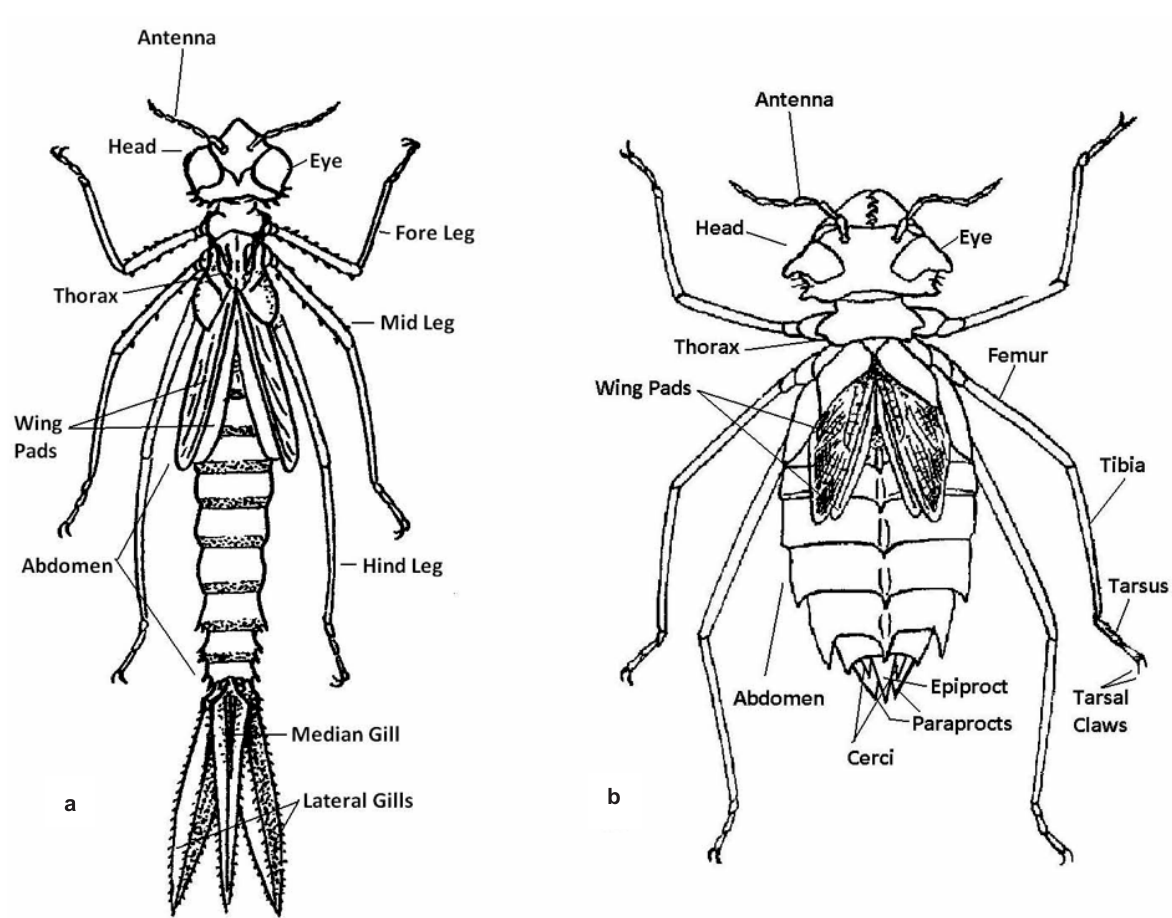
Figure 4 a–b. Odonata Morphology [figs. modified from Fraser 1919b (pl. XXXII fig. 3, pl. XXXVI, fig. 3)]. a - dorsal view of Damselfly larva Protoneuridae: Disparoneura spec.; b - dorsal view of Dragonfly larva Libellulidae: Tramea